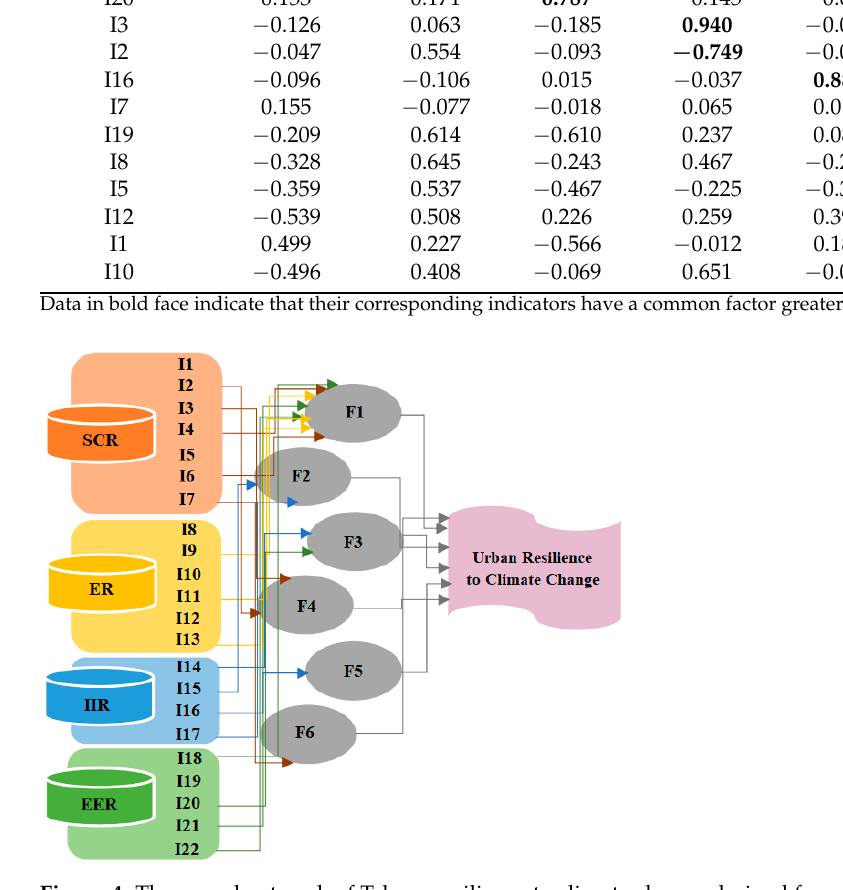
Figure 4. The causal network of Tehran resilience to climate change derived from construct factors. Urban Sci. 2023 , 7 , x FOR PEER REVIEW